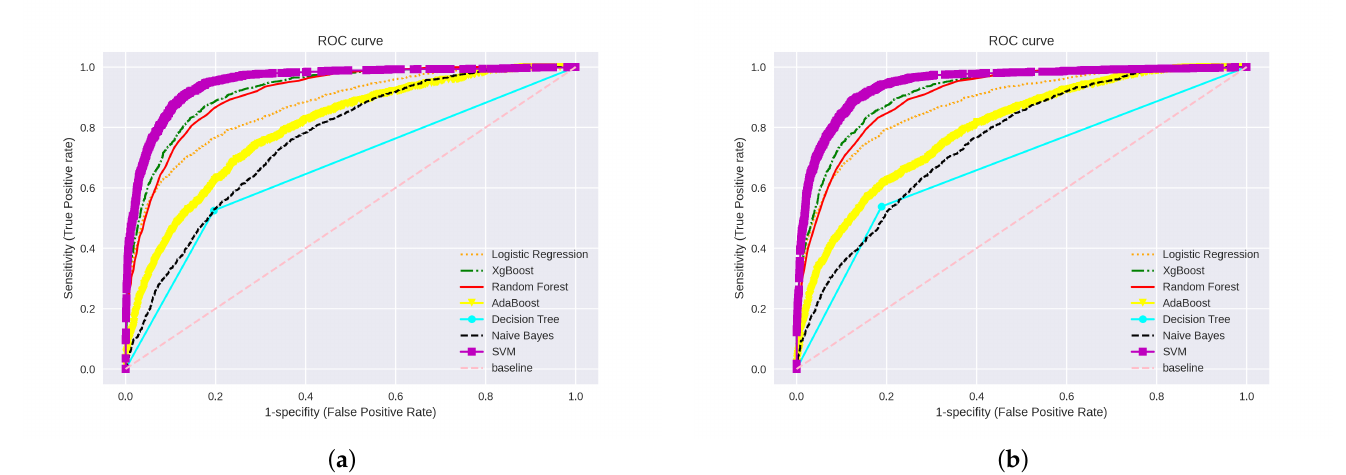
Figure 8. Visualisation of the ROC curves of traditional classifiers using hybrid: ( a ) TF-IDF with Glove and ( b ) TF-IDF with FastText word embedding techniques.